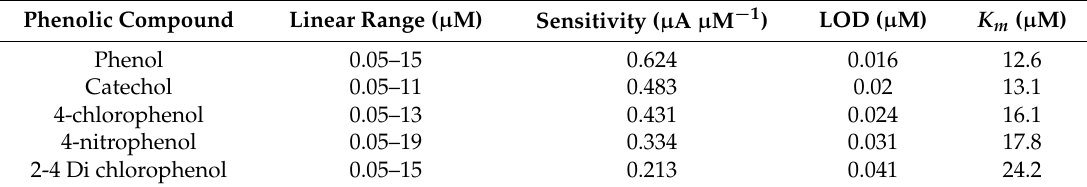
Table 1. Response characteristics of the tyrosinase biosensor towards phenolic compounds. Phenolic